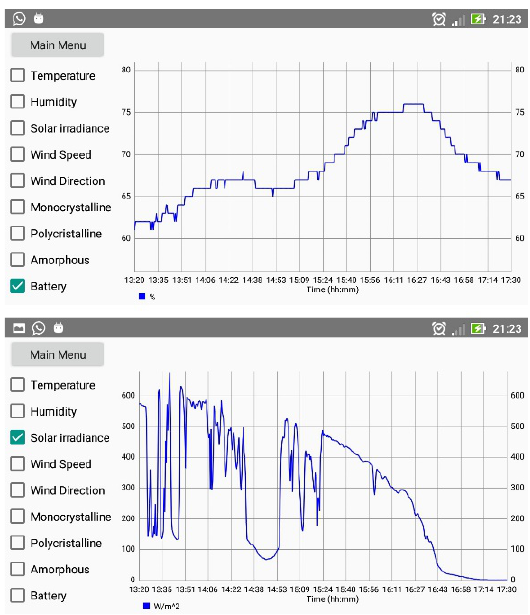
Figure 15. Measurements of the weather station battery capacity (with recharging though a PV module) and the solar irradiance along the time.